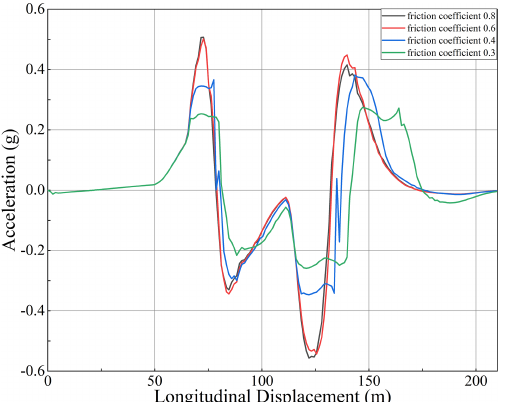
Figure 11. Steering angle at different speeds.